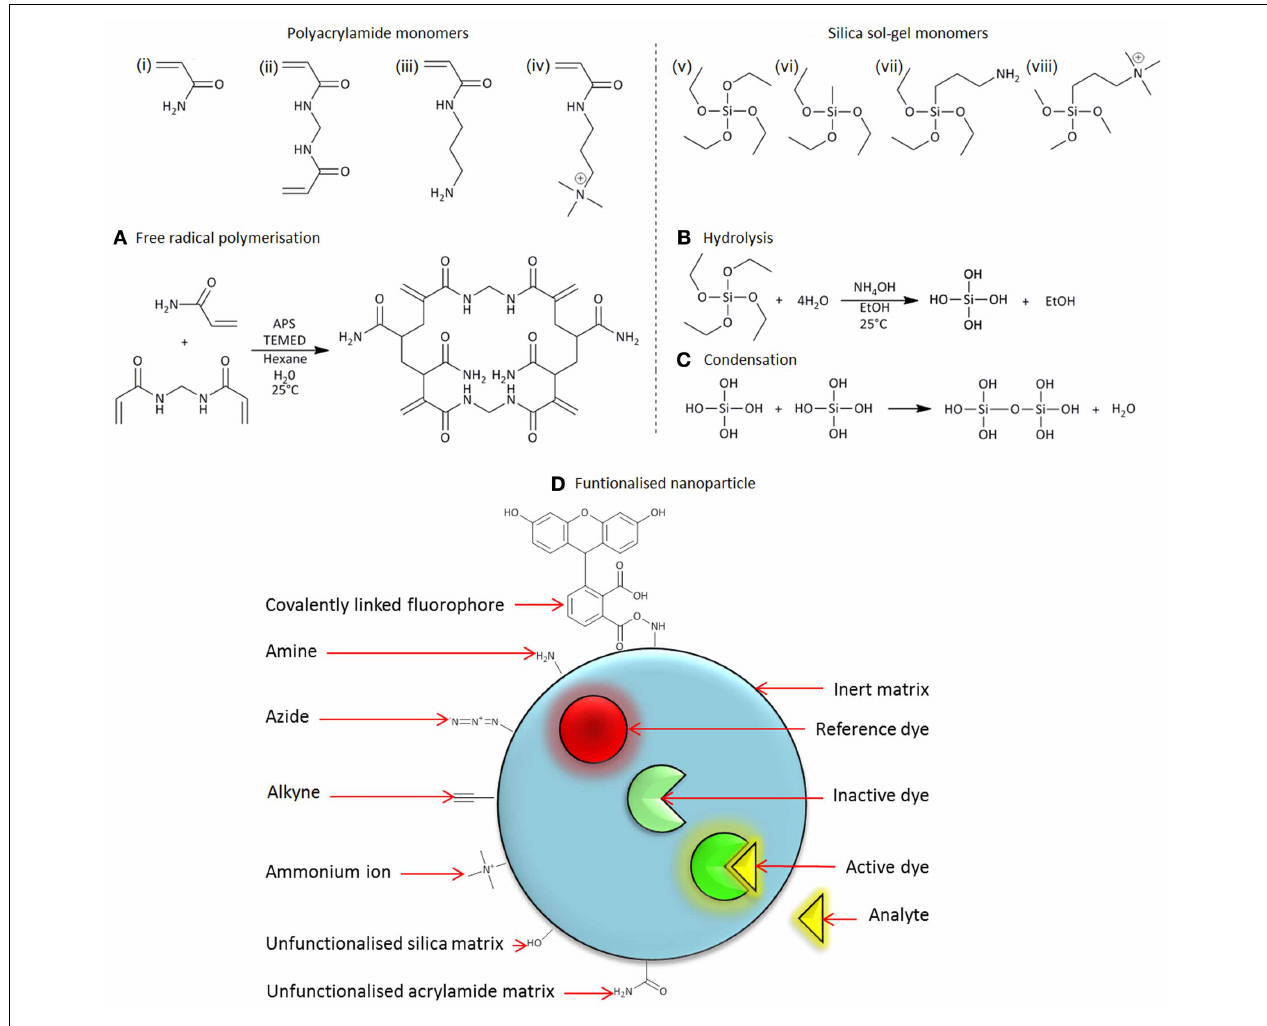
FIGURE 1 | Monomers (i–iv) and (v–viii) are used to synthesize polyacrylamide and silica sol-gel nanoparticles, respectively: (i) acrylamide, (ii) N,N (cid:2) -methylenebis(acrylamide), (iii) N-(3-aminopropyl) methacrylamide (APMA), (iv) (3-acryamidopropyl)trimethylammonium (ACTA), (v) tetraethoxysilane (TEOS), (vi) methyltriethoxysilane